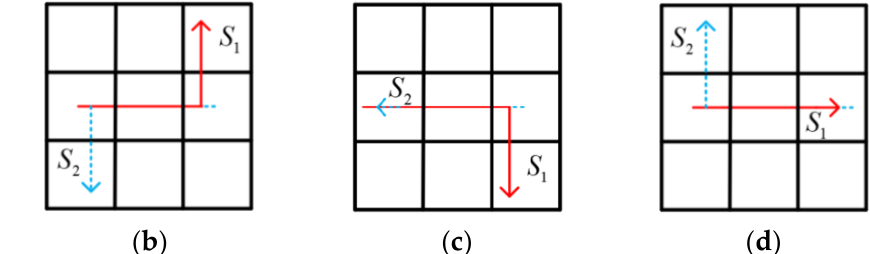
Figure 7. Schematic diagram of the third type of collision avoidance. ( a ) Situation 1; ( b ) Situation 2; ( c ) Situation 3; ( d ) Situation 4.